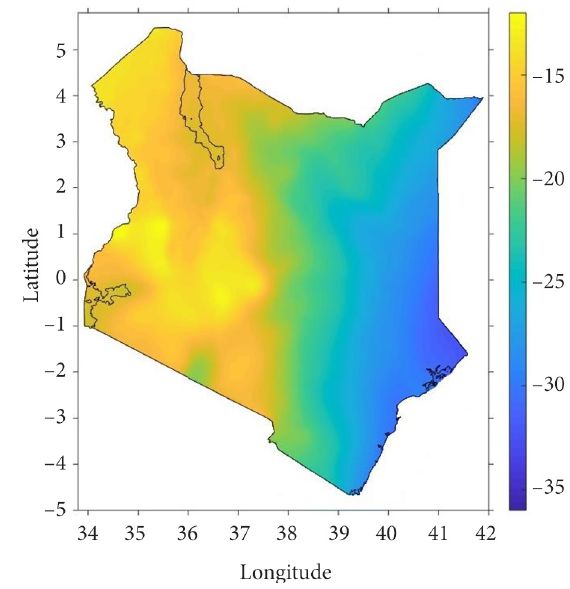
Figure 6. Spatial distribution of the differences between observed and EIGEN-6C4 implied free-air gravity anomalies over Kenya (units are in mGal)